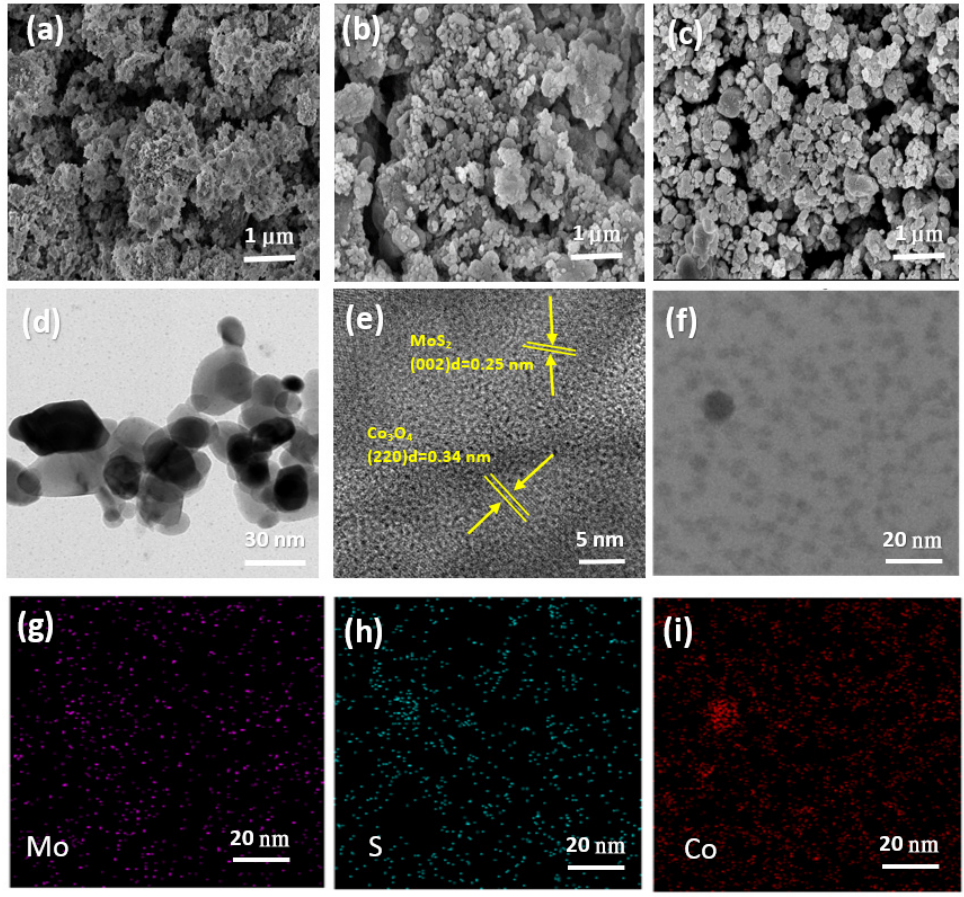
Figure 2. SEM images ( a ) MoS 2 ( b ) Co 3 O 4 ( c ) MoS 2 /Co 3 O 4 , ( d ) TEM and ( e ) HRTEM images of MoS 2 /Co 3 O 4 , ( f – i ) Elemental mapping images of MoS 2 /Co 3 O 4 nanohybrids with elemental distribution of Mo, S, and Co.